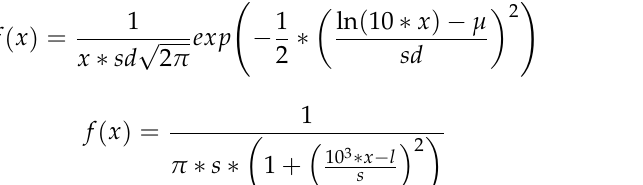
60Al 2 O 3 /40PLA sample 1 ( A ) and 2 ( B ).